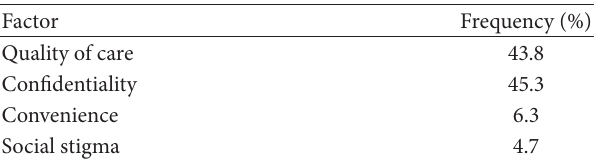
Table 5: Most important factor influencing top pick for inpatient